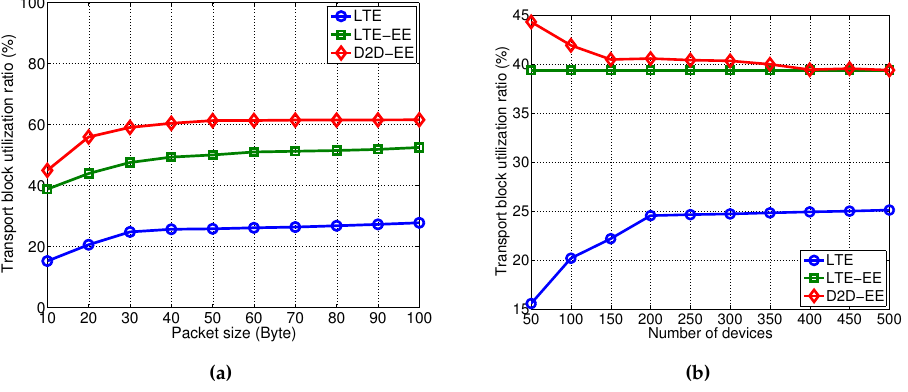
Figure 4. Transport Block utilization. ( a ) Varying the packet size (number of devices is 50); ( b ) Varying the number of devices (data size is 10